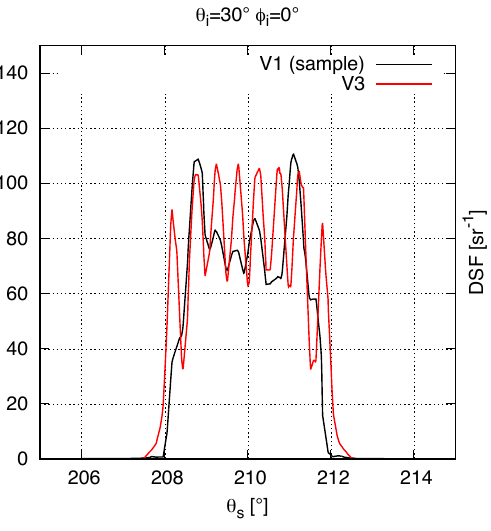
Figure 8. Biconical (direct) transmission: Measurements V1 (black) and model V3 (red) for φ i = 0 ◦ and θ i = 30 ◦ . The measurements show irregularities resulting from the non-uniformity of the sample and the reference